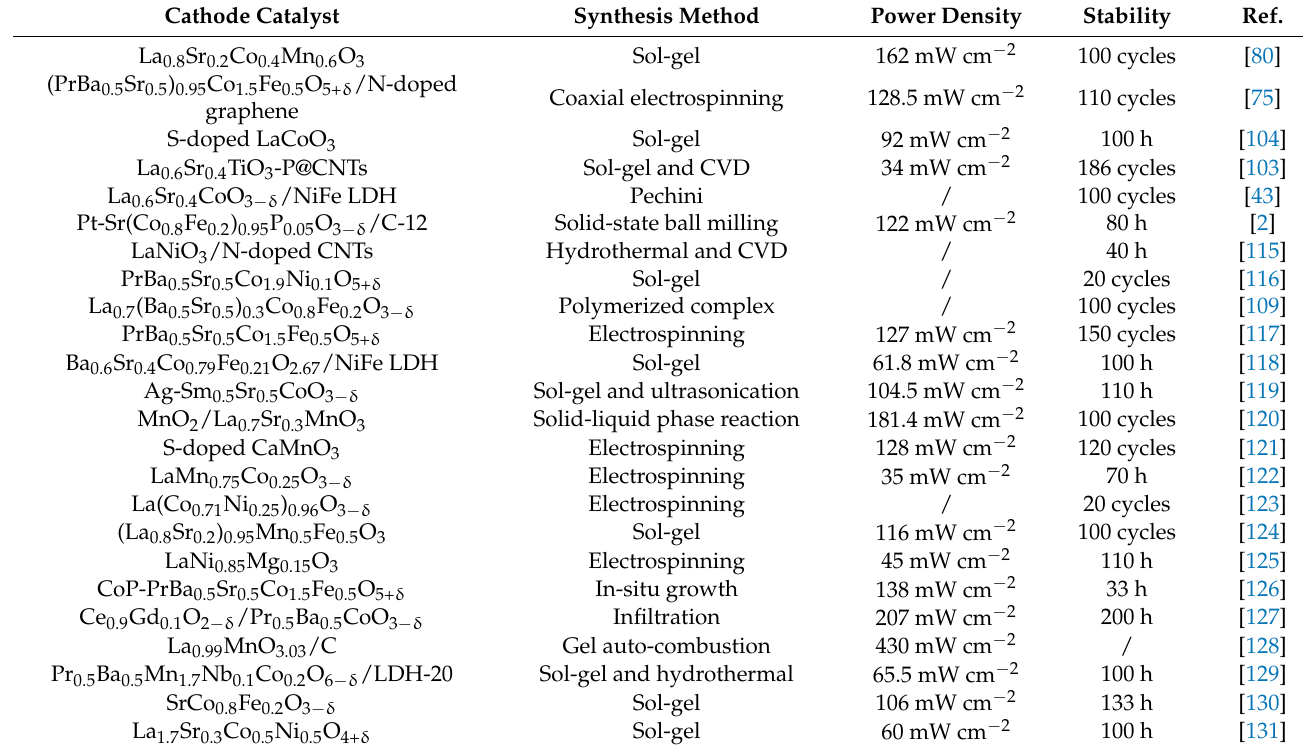
Table 1. Comparison of the performances of ZAB based on perovskite oxide